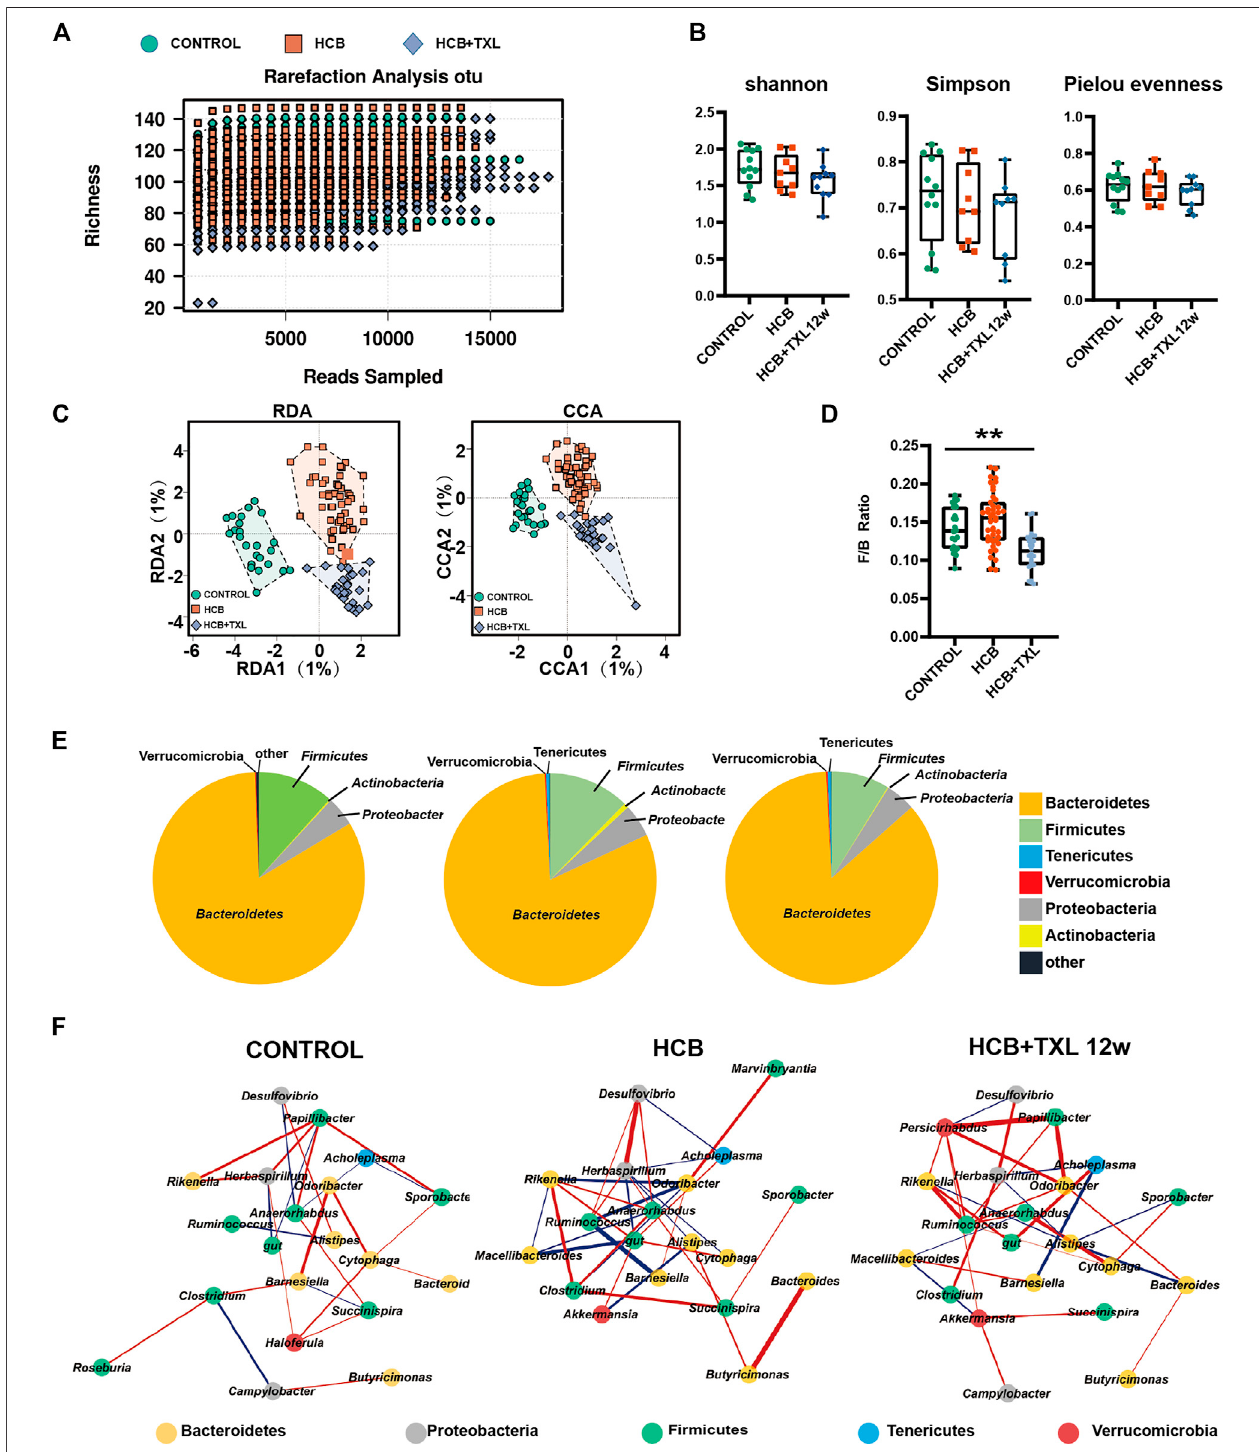
FIGURE 3 | HCB and TXL signi fi cantly changed intestinal fl ora composition (A) Rarefaction curves of ASV numbers detected by 200 random samplings in CONTROL (n = 24), HCB (n = 52) and TXL treatment (n = 28) groups. The slope of the curve for each sample is close to zero when the sequencing depth is suf fi cient to covermostoftheintestinal fl ora (B) Analysisof α diversityofintestinal fl orainrabbits.Shannonindex,SimpsonindexandPielouevennesswereperformed. (C) Analysisof β diversityofintestinal fl orainrabbits.RDAandCCAwereperformedtocalculatethedistancesbetweenfecalsamplesfromtherabbitsofCONTROL,HCBandTXL + TXL12w groups. Each point represents a sample. A clear separation is observed between the samples of different groups (D) The ratio of Firmicutes to Bacteroidetes